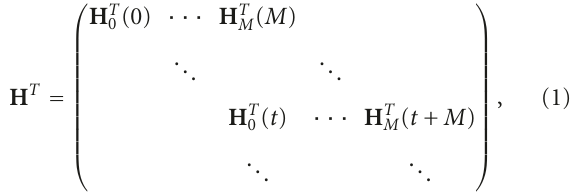
Figure 1: An example parity-check matrix, H T , for a rate-1 / 2 LDPC-CC. The row indices correspond to symbols (i.e., channel bits), and the column indices correspond to parity check equations.